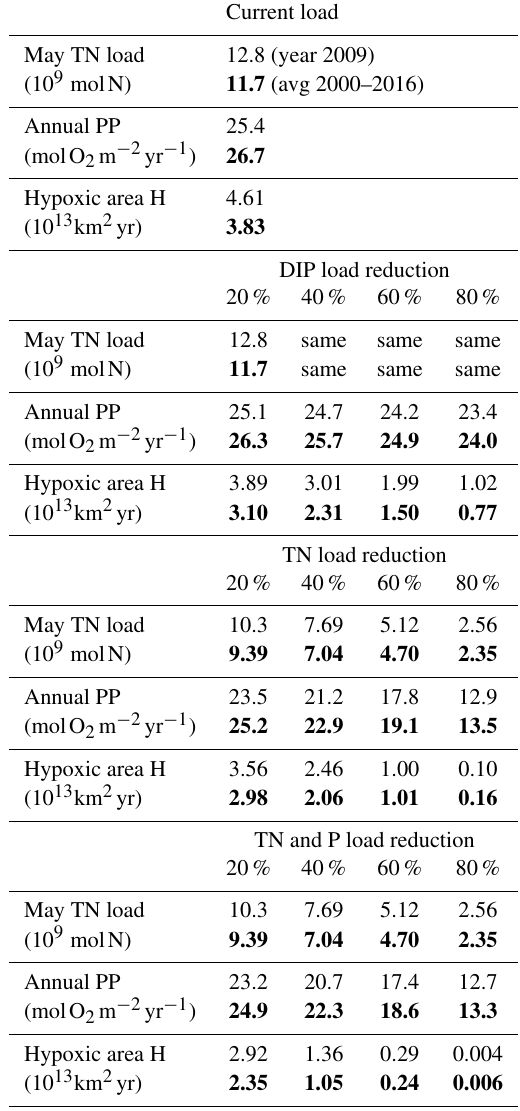
Table 1. May total nitrogen (TN) load, simulated annual primary production (PP) and annually integrated hypoxic area H for 2009 (normal font) and averaged over the years 2000 to 2016 (in bold) for current loads and selected nutrient load reduction